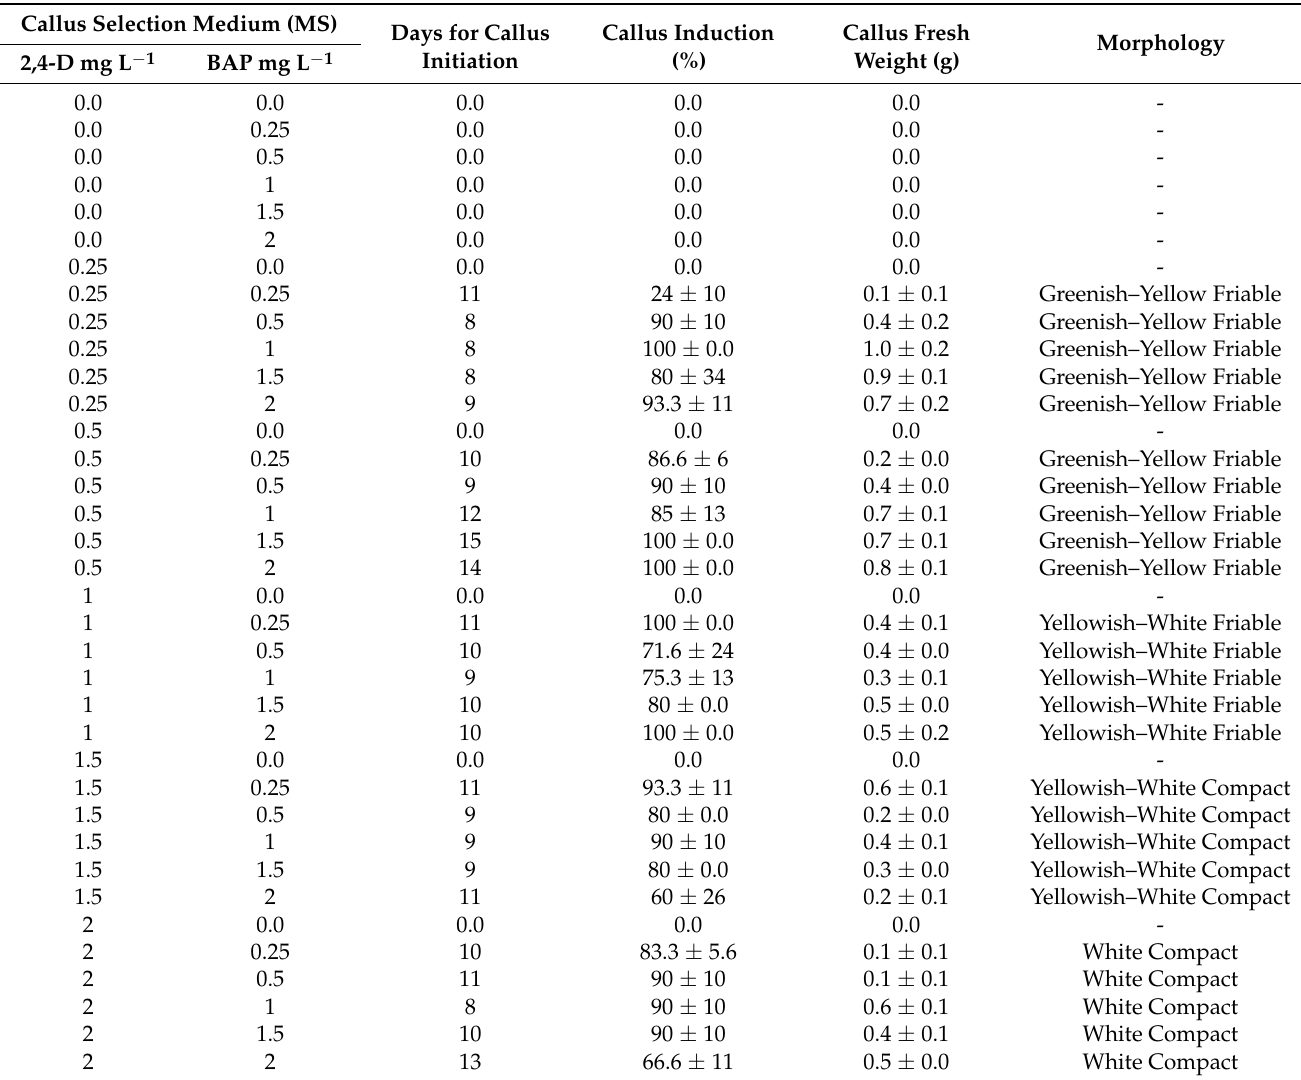
Table 1. Effect of different concentrations of 2,4-D and BAP on callus induction and callus fresh weight derived from Carum copticum stem explants on MS medium.